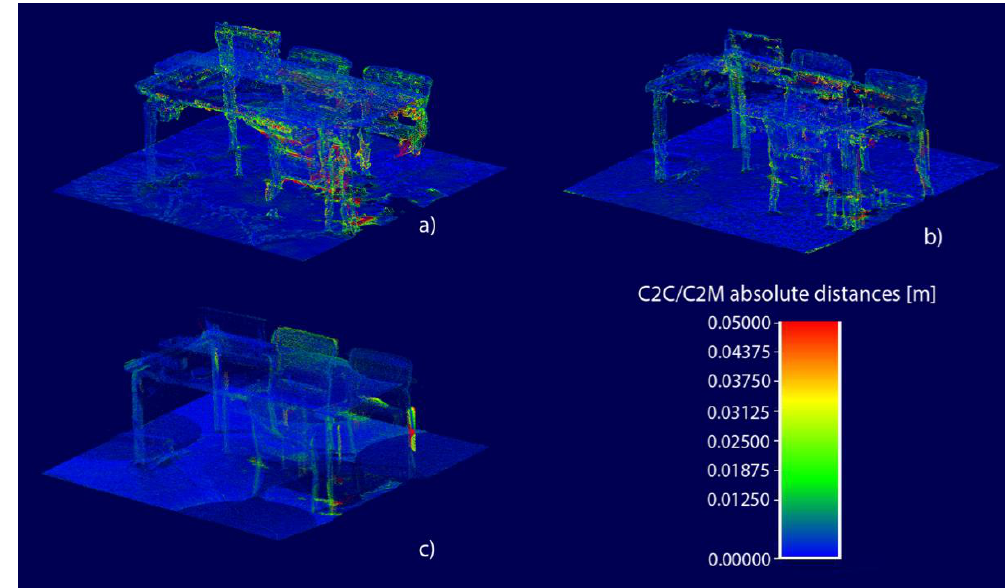
Figure 8. C2C distances of the Matterport ( a ), Matterport-processed BLK360 ( b ), and Leica-processed BLK360 ( c ) point clouds in the hall 101 segment.